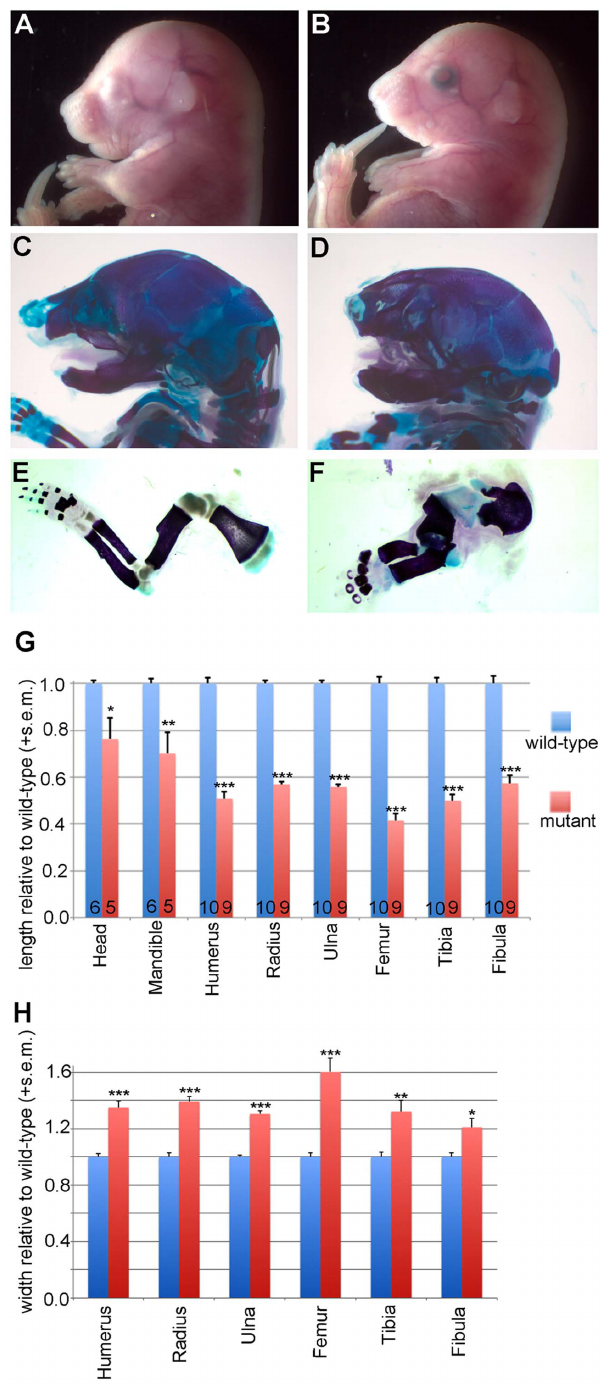
Fig. 2. MC13 phenotypes. Mutant embryos (B) are grossly distinguishable from wild-type littermates (A) by the shape of their heads and shortened, thickened limbs. (C–F) Skeletal preparations to highlight bones (red) and cartilage (blue) show the dramatic skeletal phenotypes in MC13 mutants (D,F). (G,H) Measurements of heads and limbs show significant shortening (G) and widening (H) of these elements in MC13 mutants (sample size indicated for each bone. *p , 0.02, **p , 0.006, ***p ,